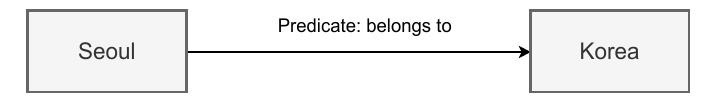
Figure 2. Triple (Seoul: belongs to